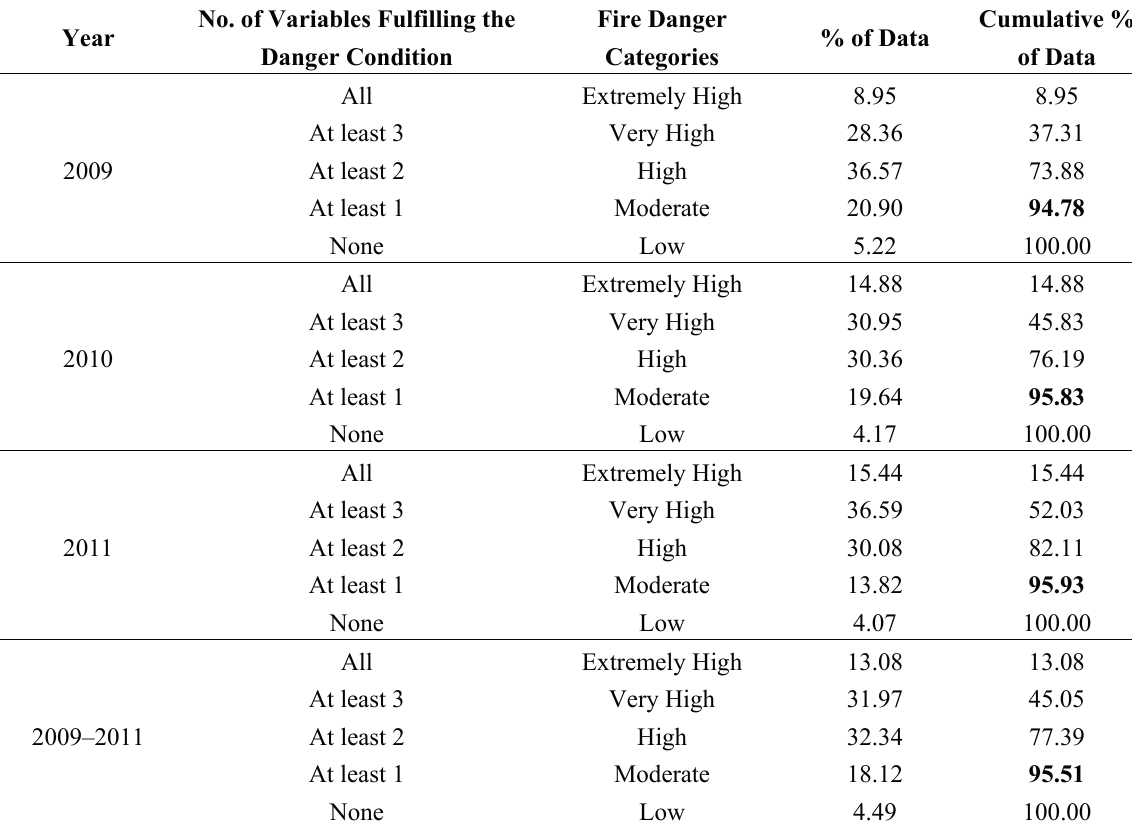
Table 1. Percentage of data under each fire danger category using the combined variable of T S , NMDI, NDVI, and PW in comparison with the fire